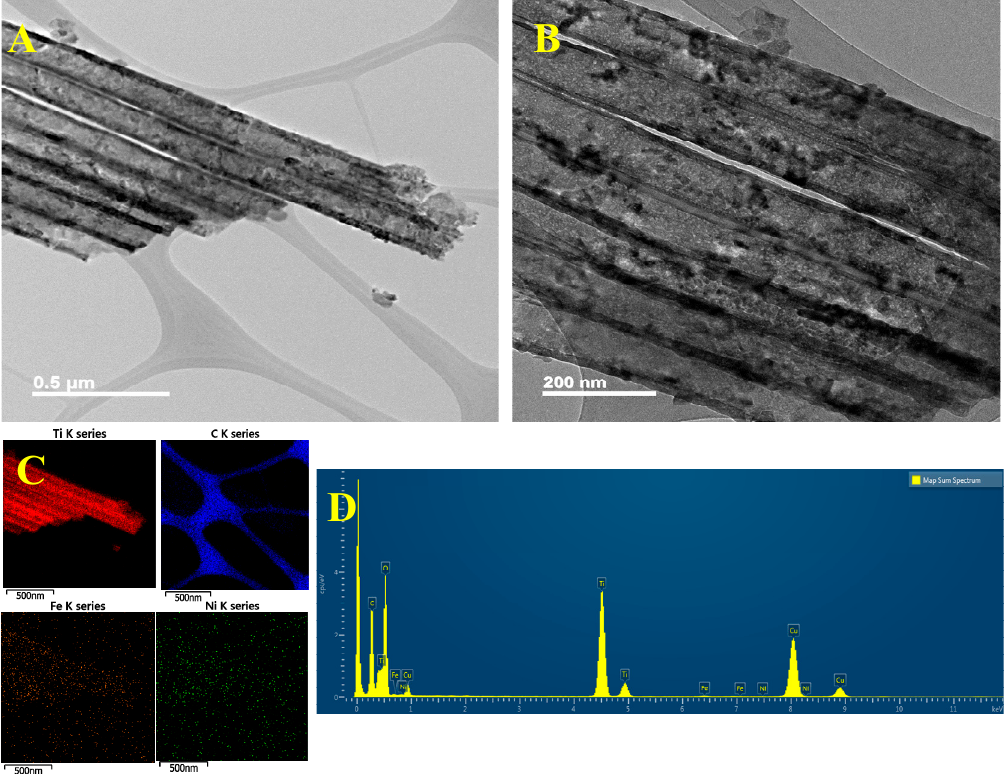
Figure 2. ( A , B ) FETEM images with different magnifications, ( C , D ) energy dispersive X-ray spectroscopy (EDS) mapping and corresponding spectra of FeNi-MOF/TNTA (0.03M_Fe/0.01M_Ni) nanocomposites.